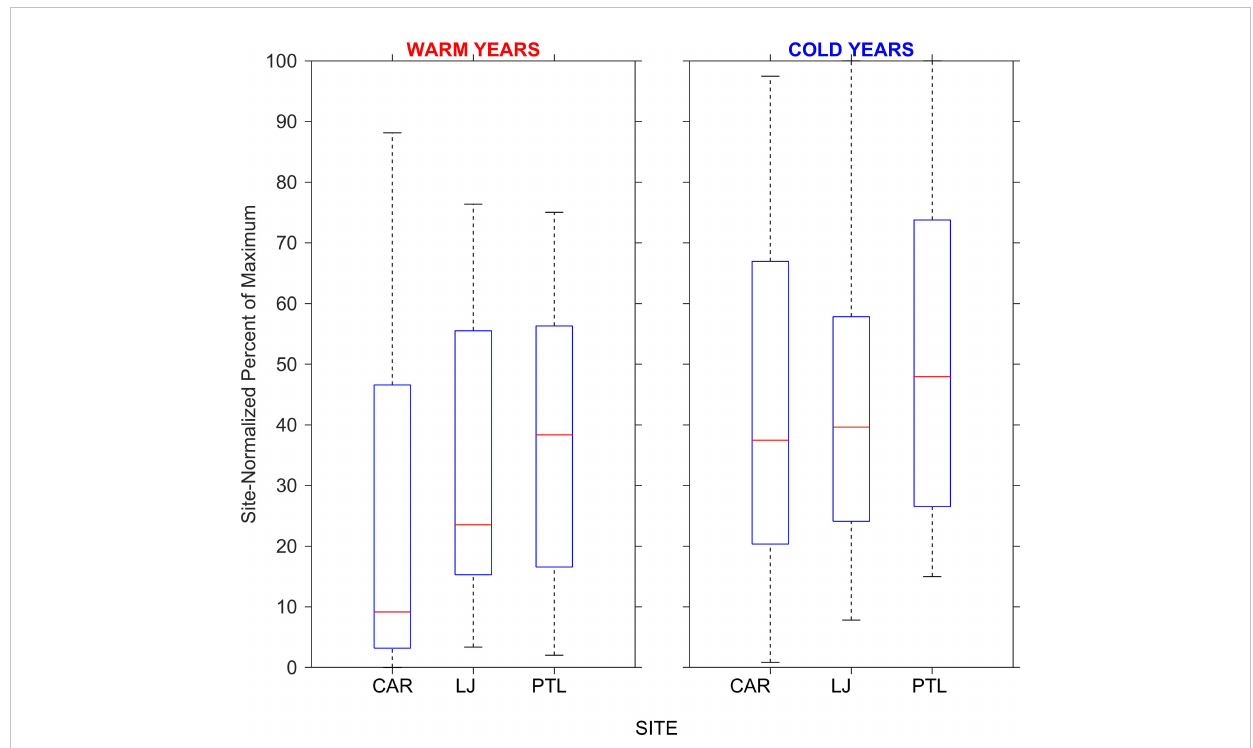
FIGURE 3 Box plot comparing the distributions of site-normalized historical kelp canopy cover at the Cardiff (CAR), La Jolla (LJ), and Point Loma (PTL) sites for the period 1983 through 2019 among nominally warm and cold years. Horizontal red bars indicate median values, blue boxes extend to the 25th and 75th percentiles and whiskers include the extreme values. Median values at CAR, LJ, and PTL were 9.2, 23.5, and 38.4 % in warm years and 37.5, 39.6, and 47.9 % in cold years respectively. Data from MBC Aquatic Sciences,